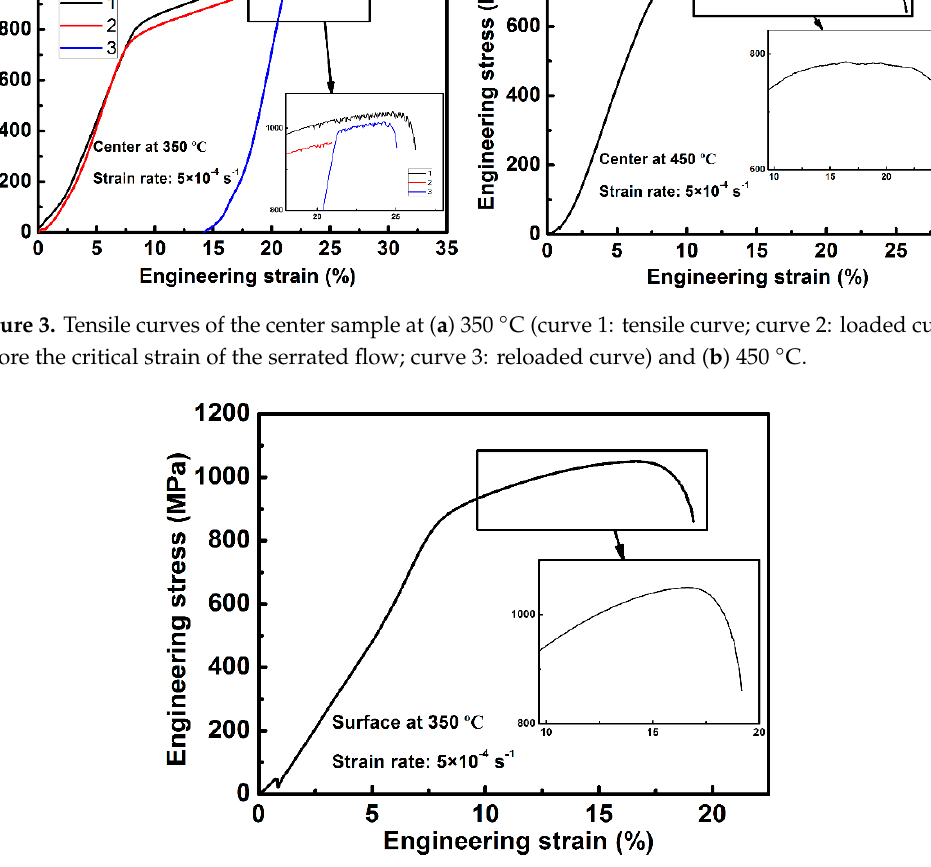
Figure 4. The tensile curve of the surface at 350 °C.